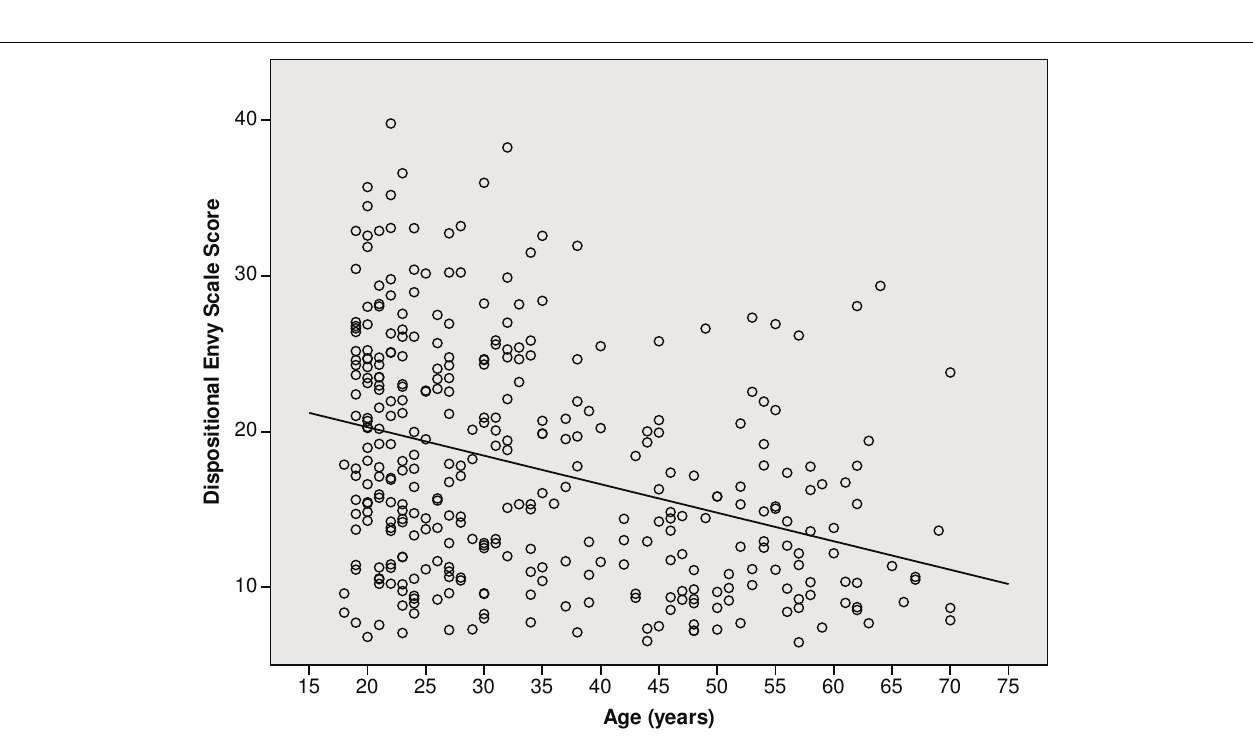
FIGURE 2 | Relationship between age and dispositional envy. Note: vertical position has been jittered for better viewing.